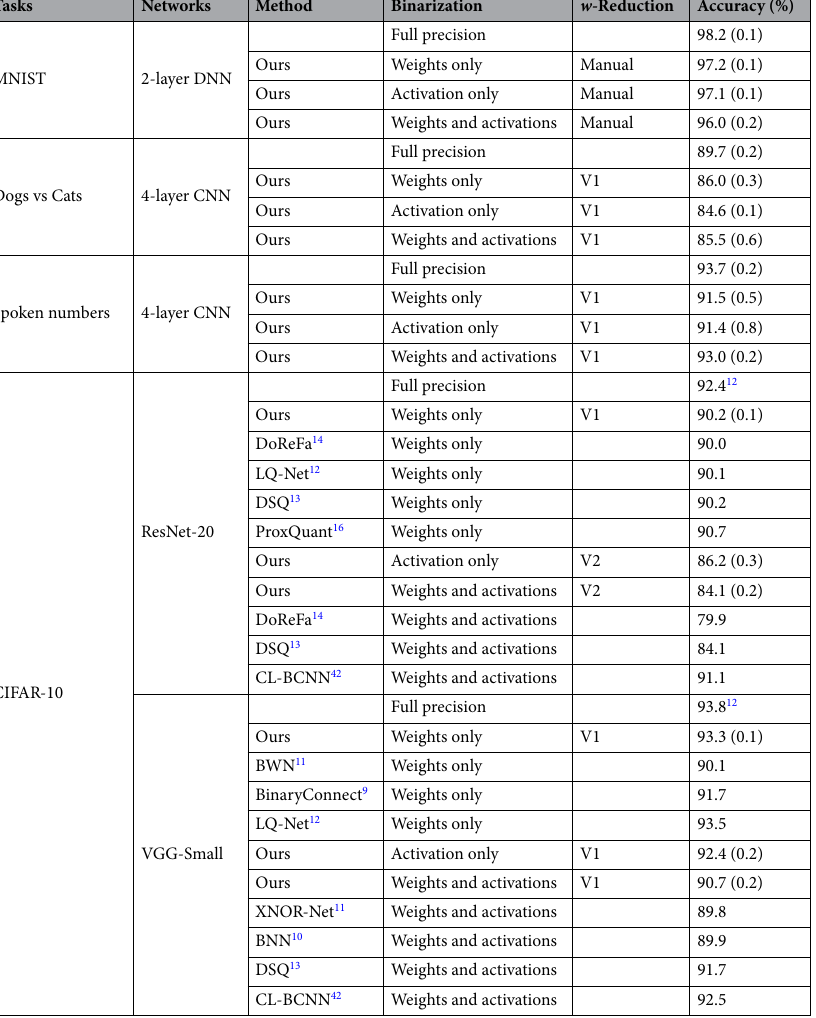
Table 1. Comparison of accuracy for all tasks. The classes in all datasets are completely